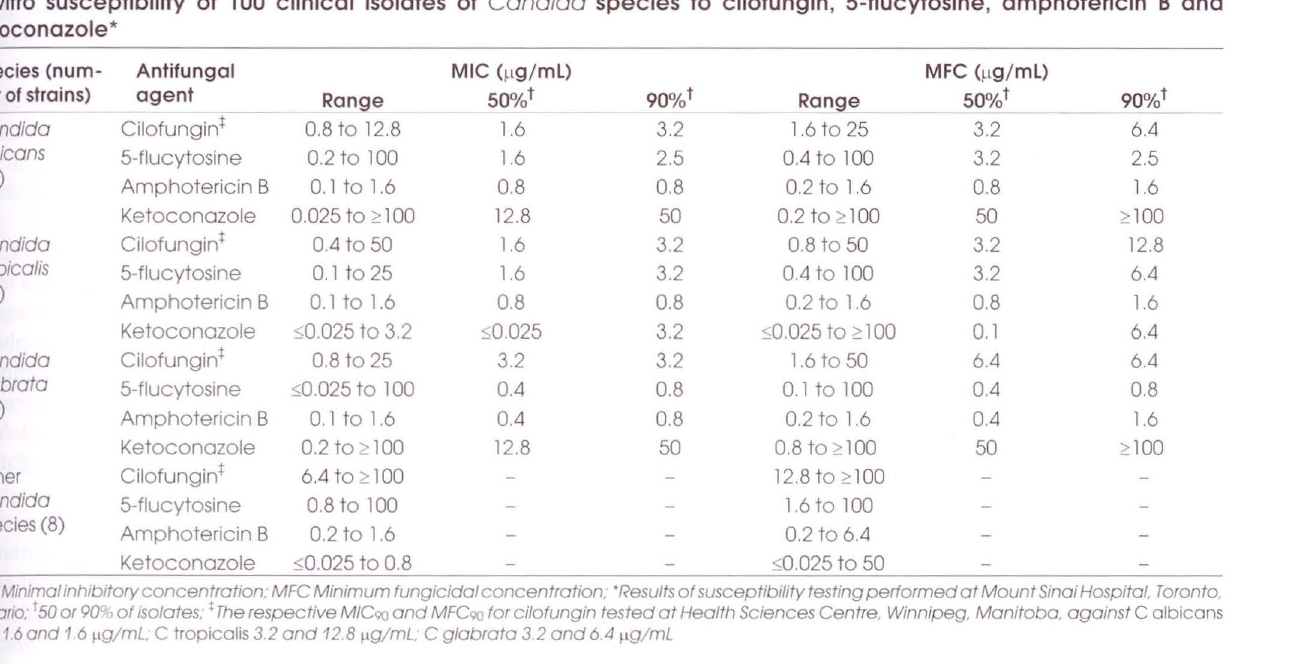
testing of U1e four antifungal agents between the 1:\vo